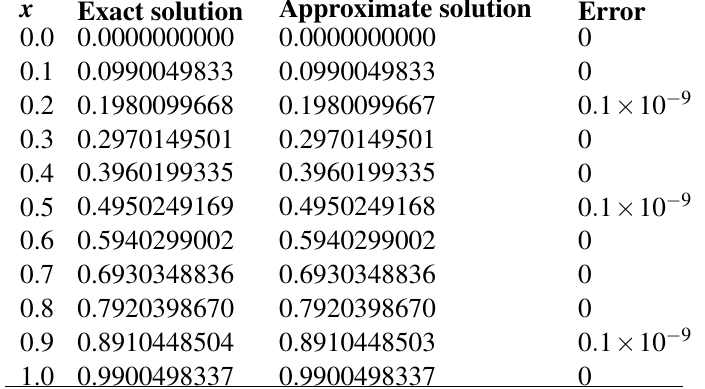
Table 1 Exact solution, approximate solution, and error values for t = 0 . 01